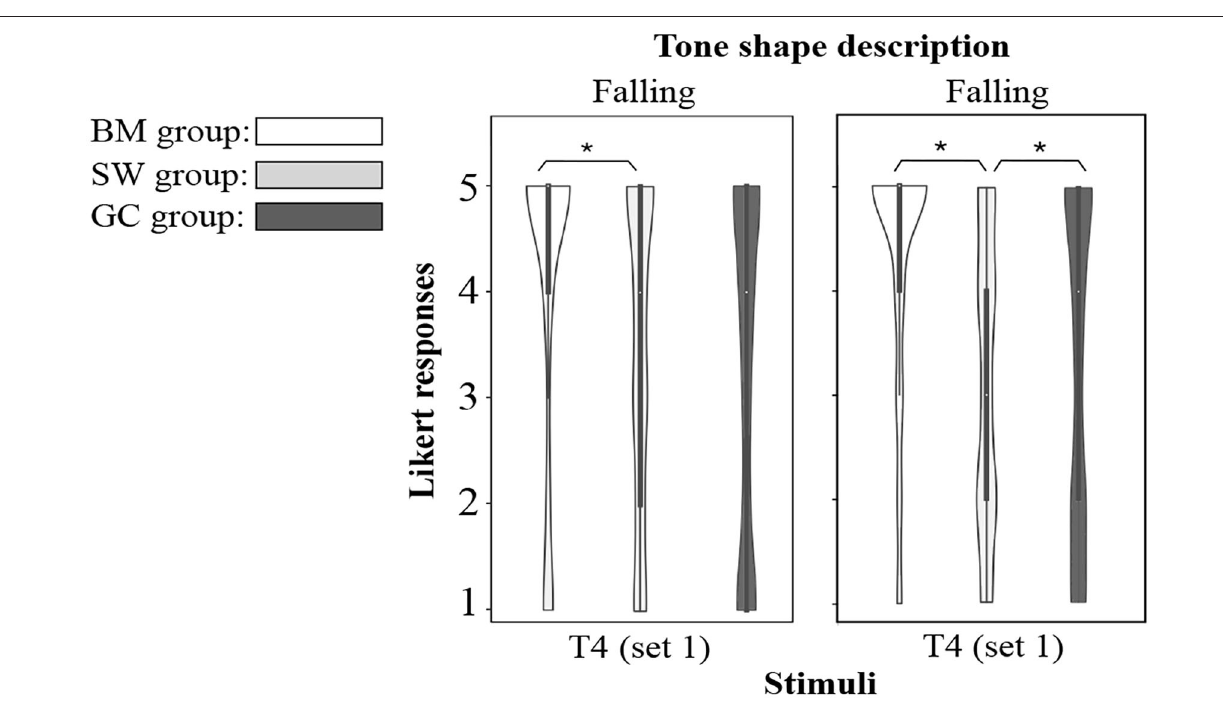
showed that the difference between “ rising ” and “ level ” of the BM group was significant, while that of the SW group was also significant but for “ level ” higher than “ rising ” ( p BM = 0.009; p SW < 0.001; p GC = 0.06). This result might be due to moving the whole curve to lower frequency zone making the gentle slope of T1 set3 more audible (refer to Figure 1 for slope